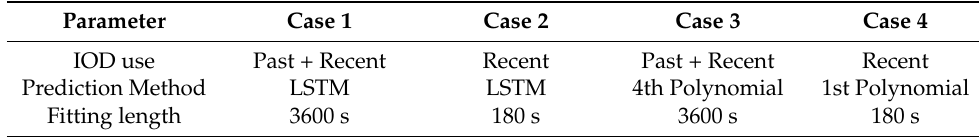
Table 2. List of RTS prediction methods in case of RTS signal